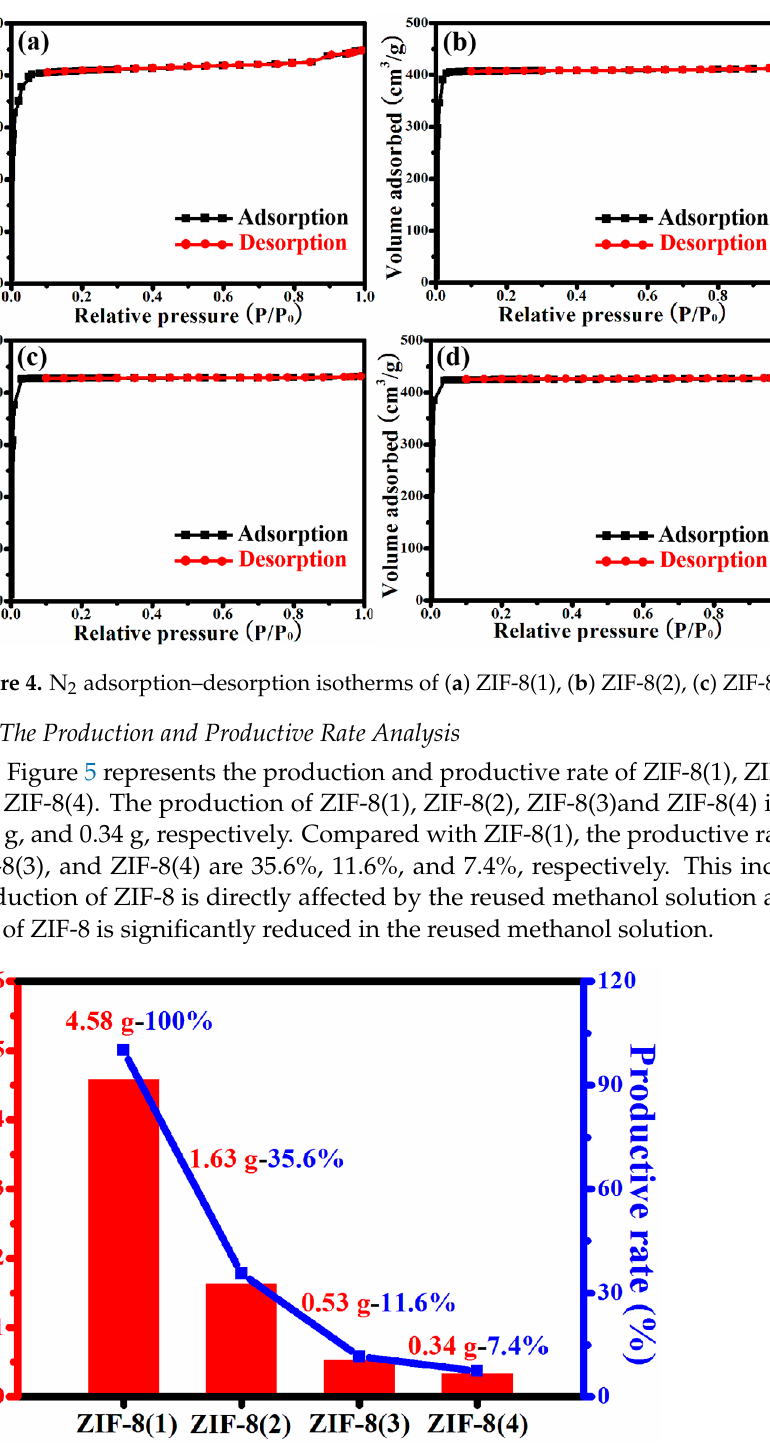
Figure 5. The production and productive rate of ZIF-8(1), ZIF-8(2), ZIF-8(3), and ZIF-8(4).